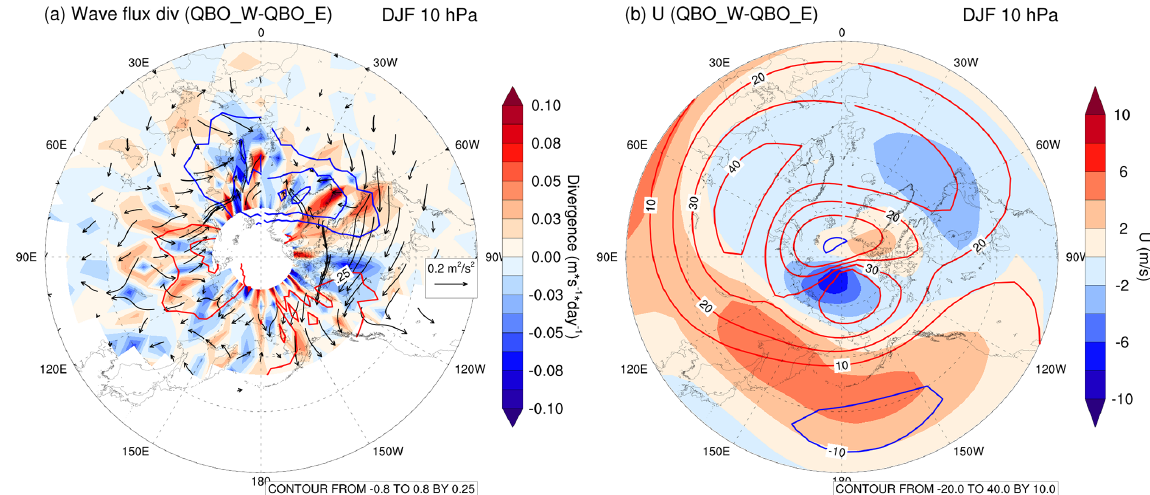
Figure 13. Influences of QBO (QBOW–QBOE) on T – N wave flux (a) and zonal winds (b) at 10hPa north of 30 ◦ N during winter (DJF), based on ERA5 data for the period 1979–2020. In panel (a) , the meridional and zonal components of the wave flux are shown as vectors, the vertical component is shown as contour lines (positive in red), and the divergence of the wave flux is shaded. In panel (b) , the climatological values of zonal wind during QBOE are shown in contour lines (solid lines for westerly, with a contour interval of 10ms − 1 ), and the anomalies are shaded. Stippled areas indicate results that are statistically significant over the 95% level, using the two-tailed Student’s t